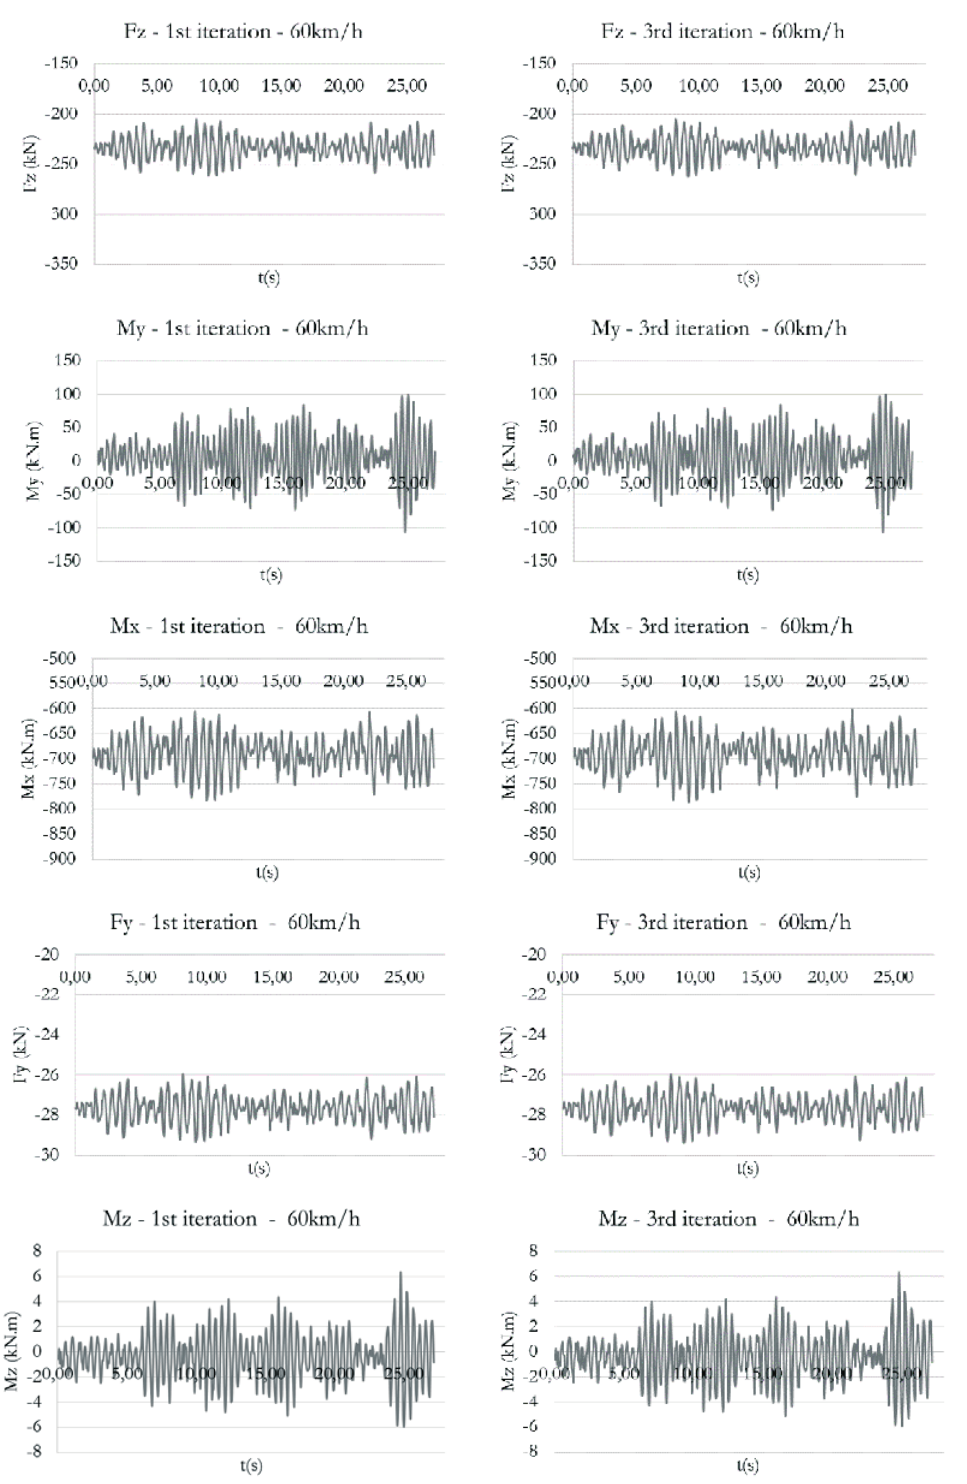
Comparison of the efforts applied to the bridge in the 1st iteration (rigid deck) and 3rd iteration with velocity of 60